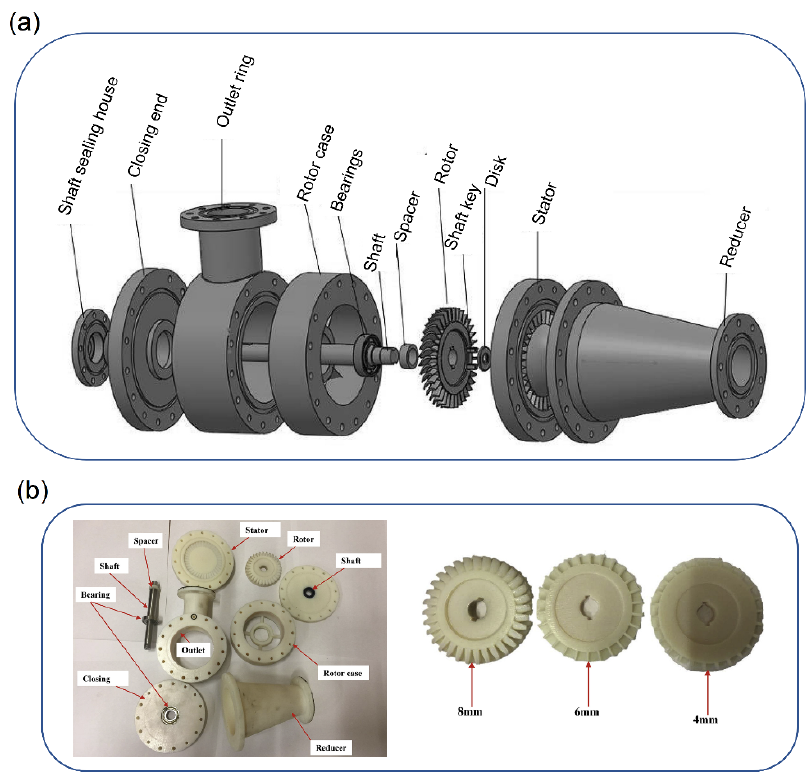
Figure 4. ( a ) Exploded schematic of micro-scale axial turbine and ( b ) left: fabricated all turbine parts and right: fabricated rotors with different blades heights (reprinted with permission from [118]).